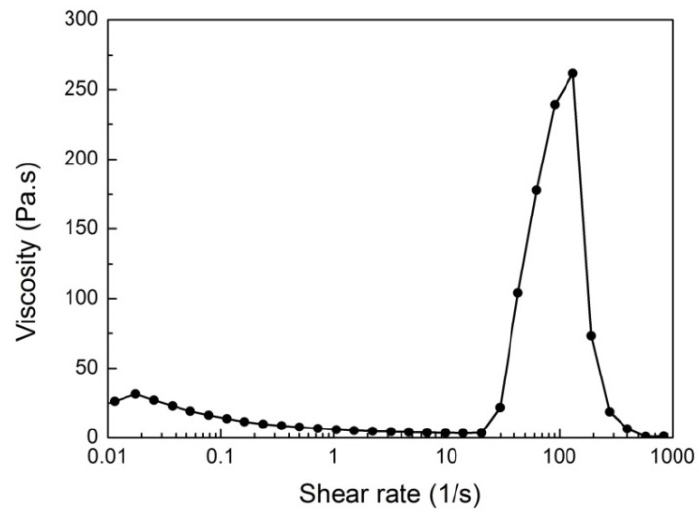
Figure 1. Viscosity versus shear rate of STF suspension.